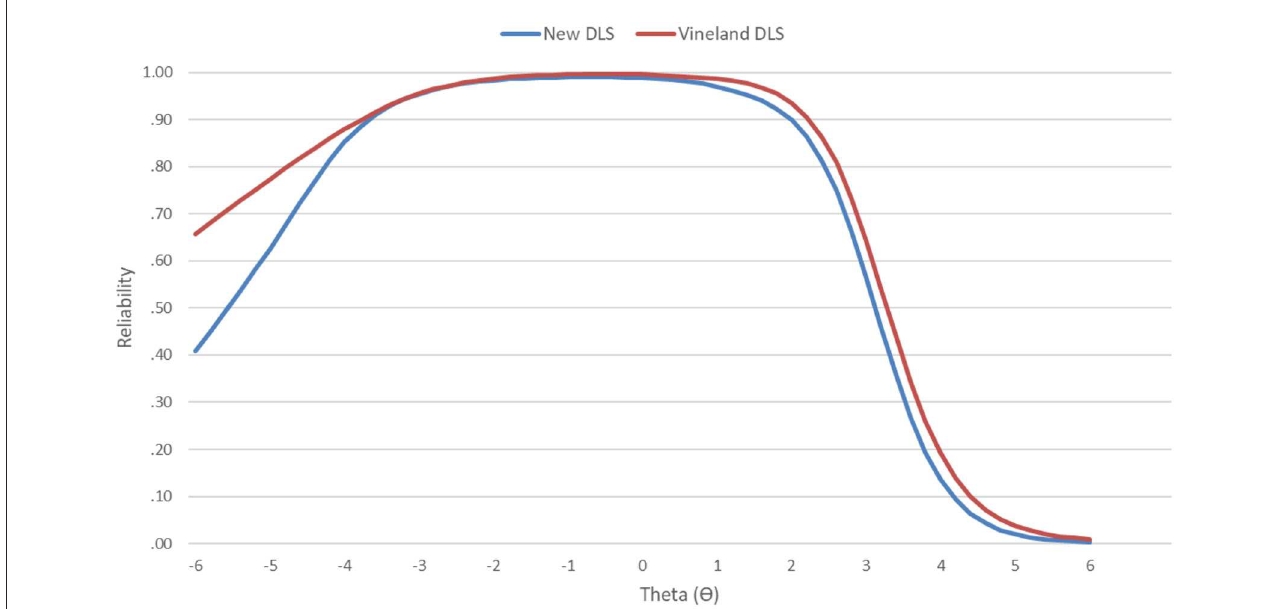
FIGURE2 Item response theory-derived conditional reliability across the latent trait for the total DLS scale and the Vineland Daily Living Skills